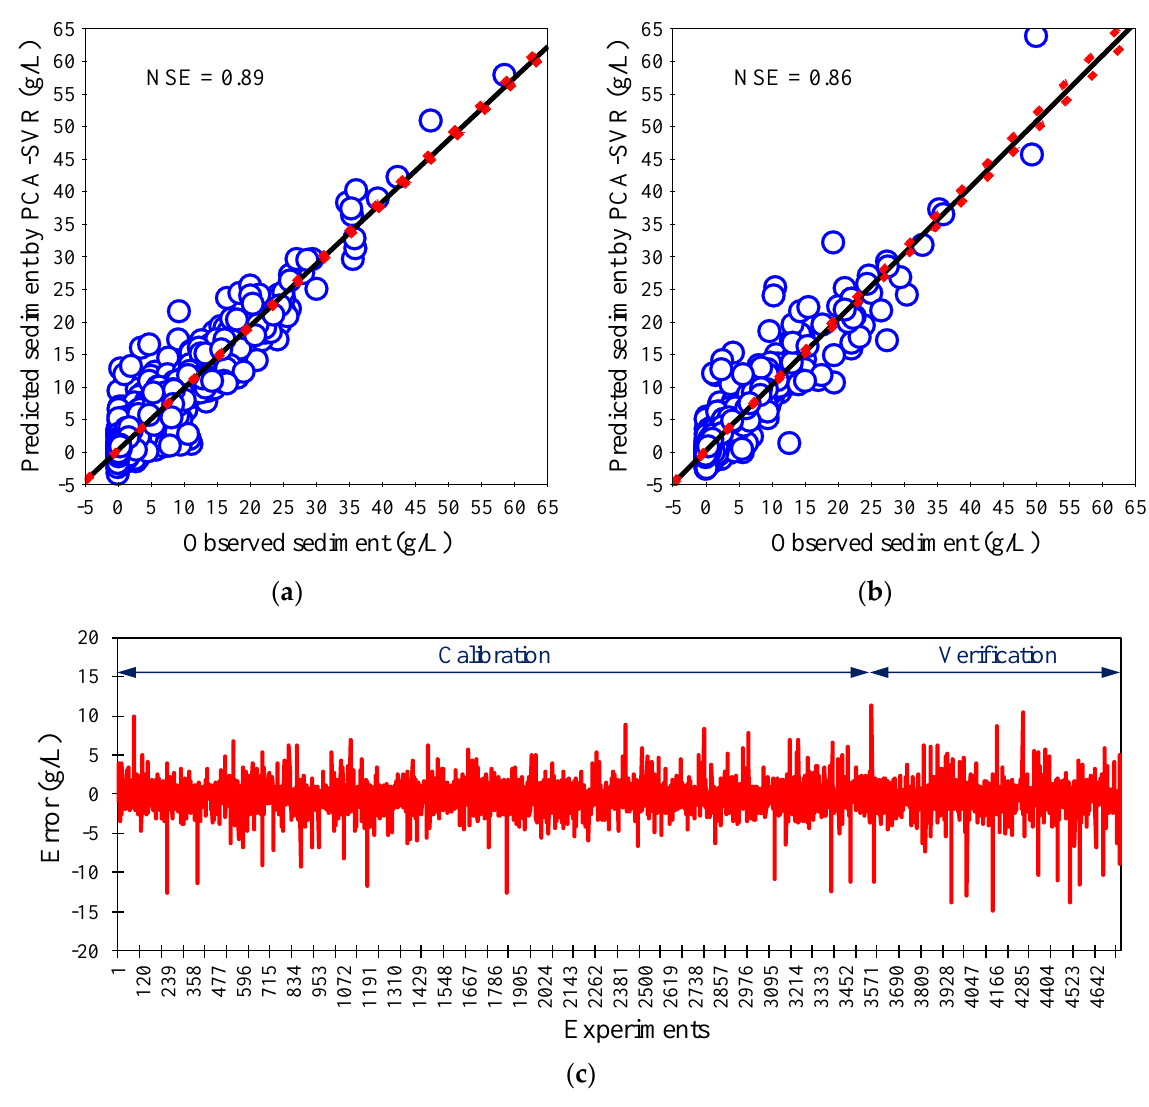
Figure 5. The scatter plots of the sediment concentrations estimated by the PCA-based RBF-SVR model and those values measured in laboratory flumes during ( a ) calibration and ( b ) verification steps. ( c ) The error between the sediment concentrations estimated by the PCA-based RBF-SVR model and those measured in laboratory flumes during both calibration and verification steps.